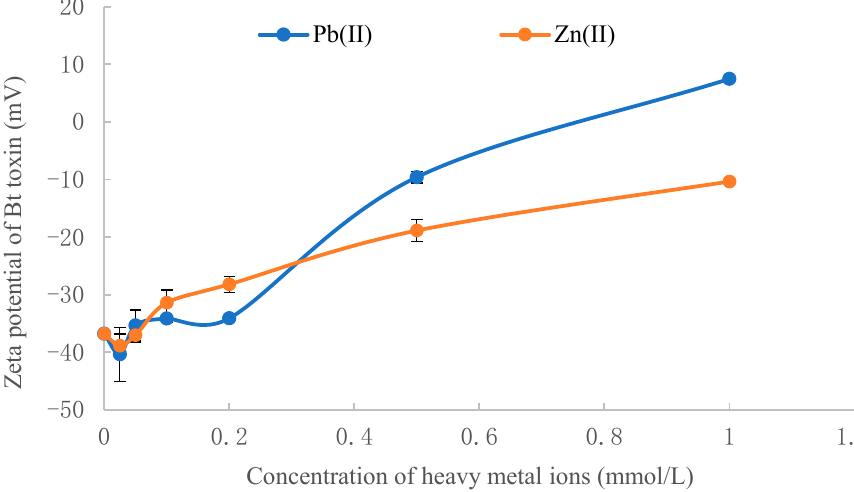
Figure 5. Effect of Pb(II) and Zn(II) concentration on the zeta potential of Bt toxin.